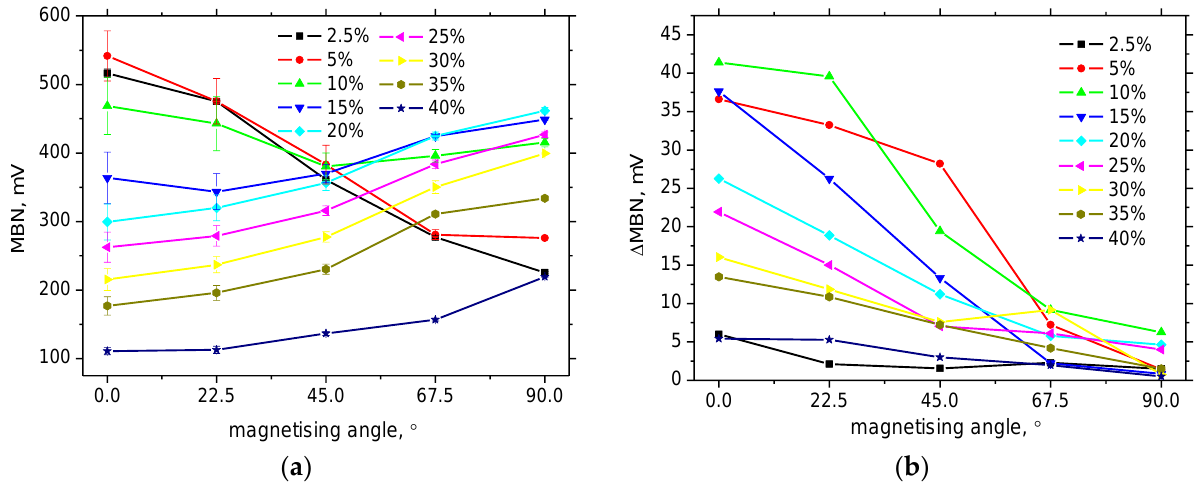
Figure 12. Asymmetry in MBN (rms values) between the positive and negative bursts. ( a ) Angular evolution of MBN with indicated error bars, ( b ) difference in MBN between the positive and negative bursts.